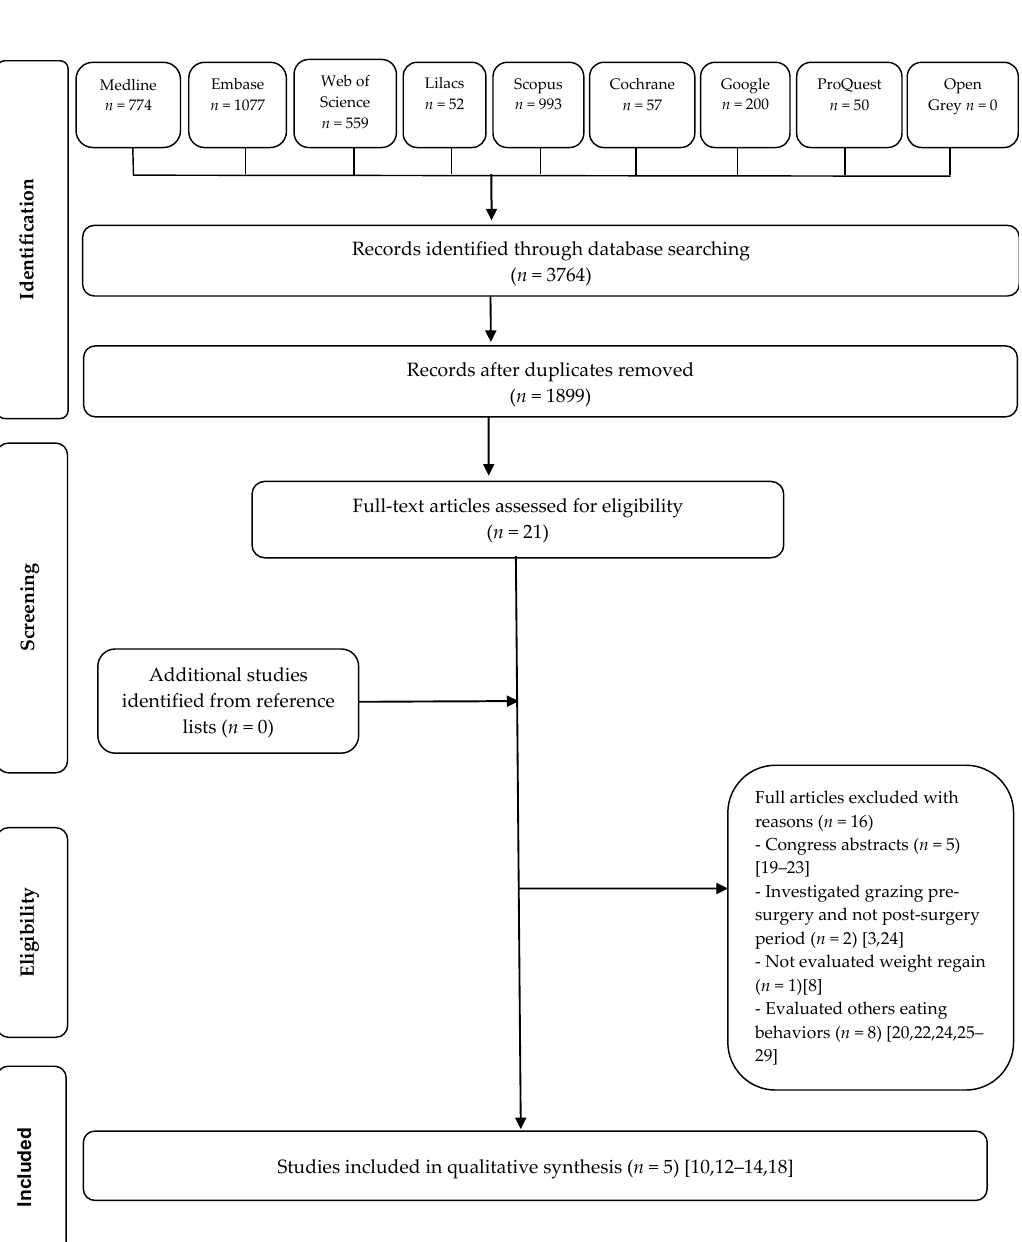
Figure 1. Flow diagram of the literature search and selection criteria.